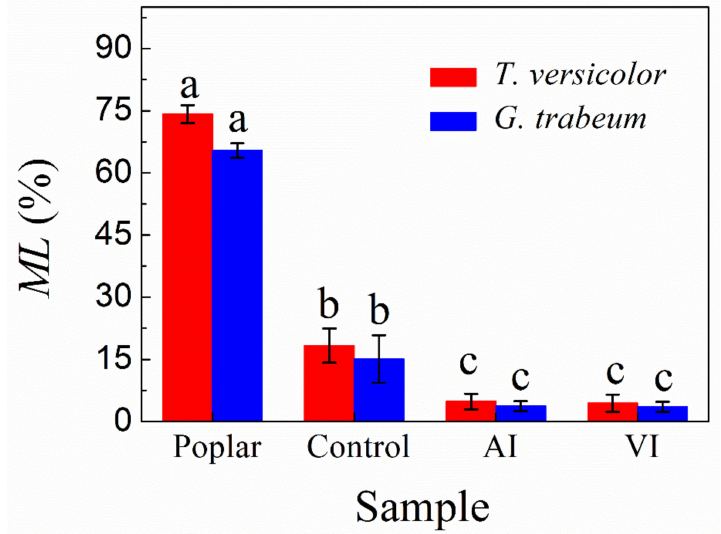
Figure 1. ML of poplar wood (reference), untreated WFMRC (control), and CuAz-treated WFMRCs after exposure to T. versicolor and G. trabeum fungi. AI: atmospheric impregnation; VI: vacuum impregnation. Error bars represent mean ± standard deviation. The average values with different letters (a, b, c) on the columns indicate a significant difference at the 0.05 level (analysis of variance (ANOVA), followed by Duncan’s multiple range